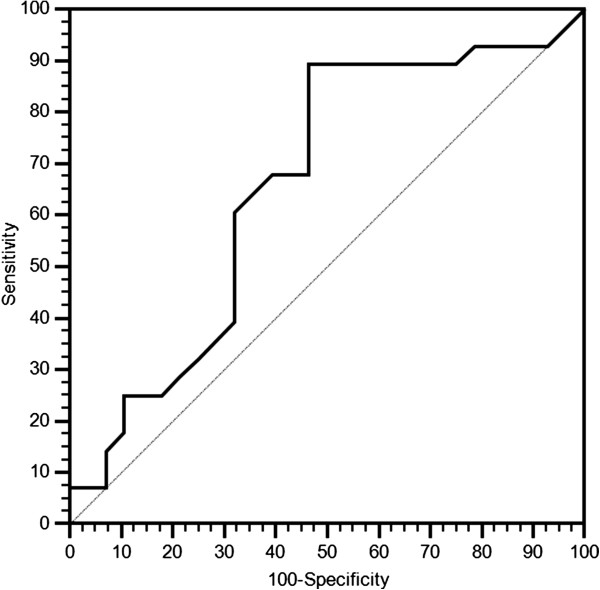
ROC curve for PFS.